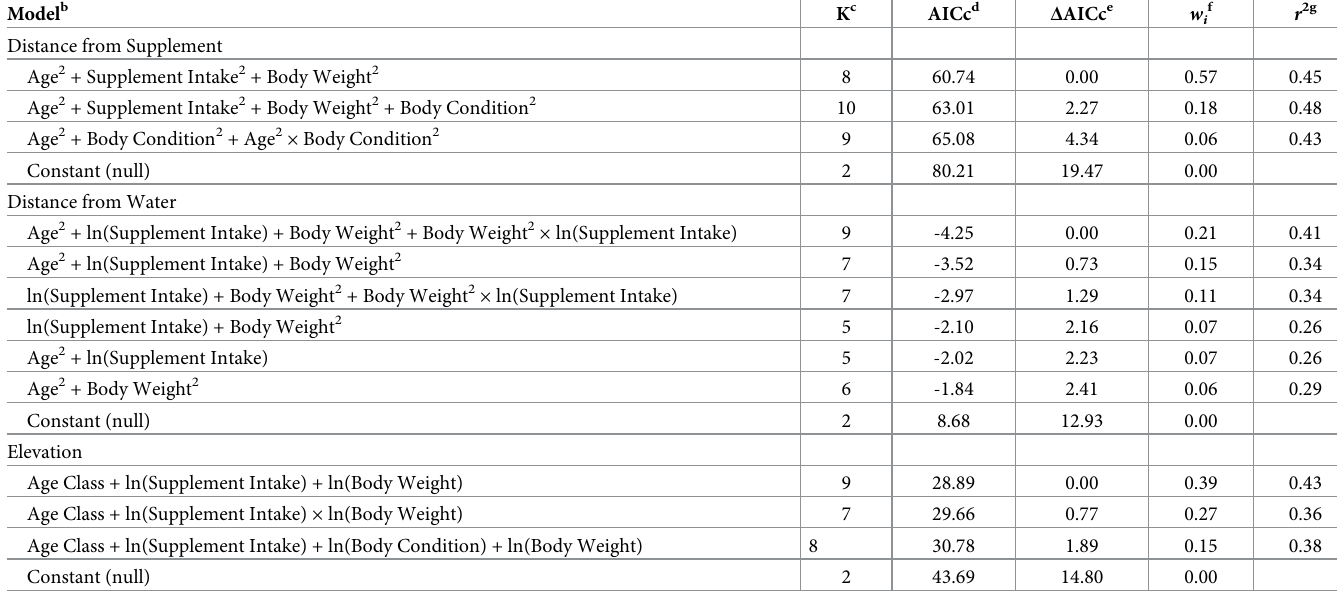
Table 3. Model selection for models evaluating the effects of cow age, body condition and supplement intake on the effect size of distance from supplement, dis- tance from water and elevation from the RUF analysis of cattle grazing dormant rangeland in 2016 – 2017 & 2017 – 2018 at the Northern Agricultural Research Center Thackeray ranch, Havre, MT.